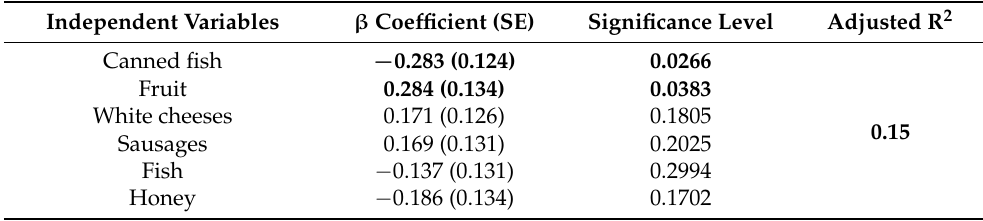
Table 8. Stepwise multiple linear regression analysis of the influence of the frequency of consuming food products on the concentration of